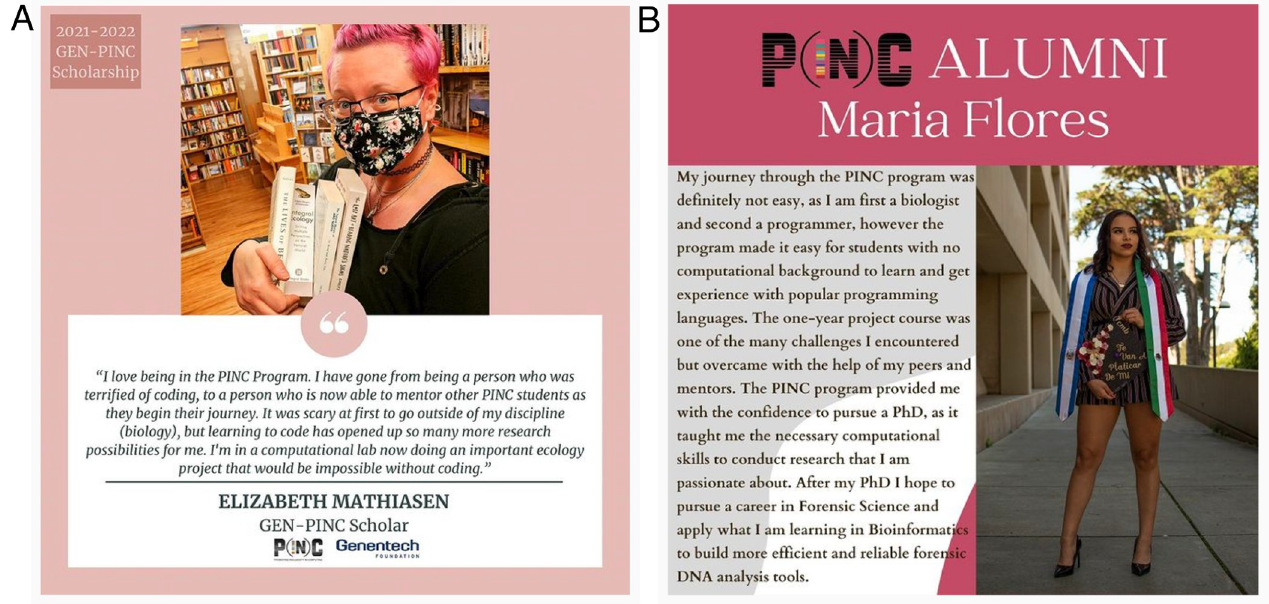
Fig 1. Two images from the PINC Instagram feed (https://www.instagram.com/sfsupinc/), where we celebrate current students and alums. On the left, Elizabeth Mathiasen (current PINC student) says: “I love being in the PINC Program . I have gone from being a person who was terrified of coding , to a person who is now able to mentor other PINC students as they begin their journey . It was scary at first to go outside of my discipline (biology) , but learning to code has opened up so many more research possibilities for me . I’m in a computational lab now doing an important ecology project that would be impossible without coding .” On the right, former PINC student and current UCLA PhD student Maria Flores says: “My journey through the PINC program was definitely not easy , as I am first a biologist and second a programmer , however , the program made it easy for students with no computational background to learn and get experience with popular programming languages . The one-year project course was one of the many challenges I encountered but overcame with the help of my peers and mentors . The PINC program provided me with the confidence to pursue a PhD , as it taught me the necessary computational skills to conduct research that I am passionate about . After my PhD , I hope to pursue a career in Forensic Science and apply what I am learning in Bioinformatics to build more efficient and reliable forensic DNA analysis tools ”.